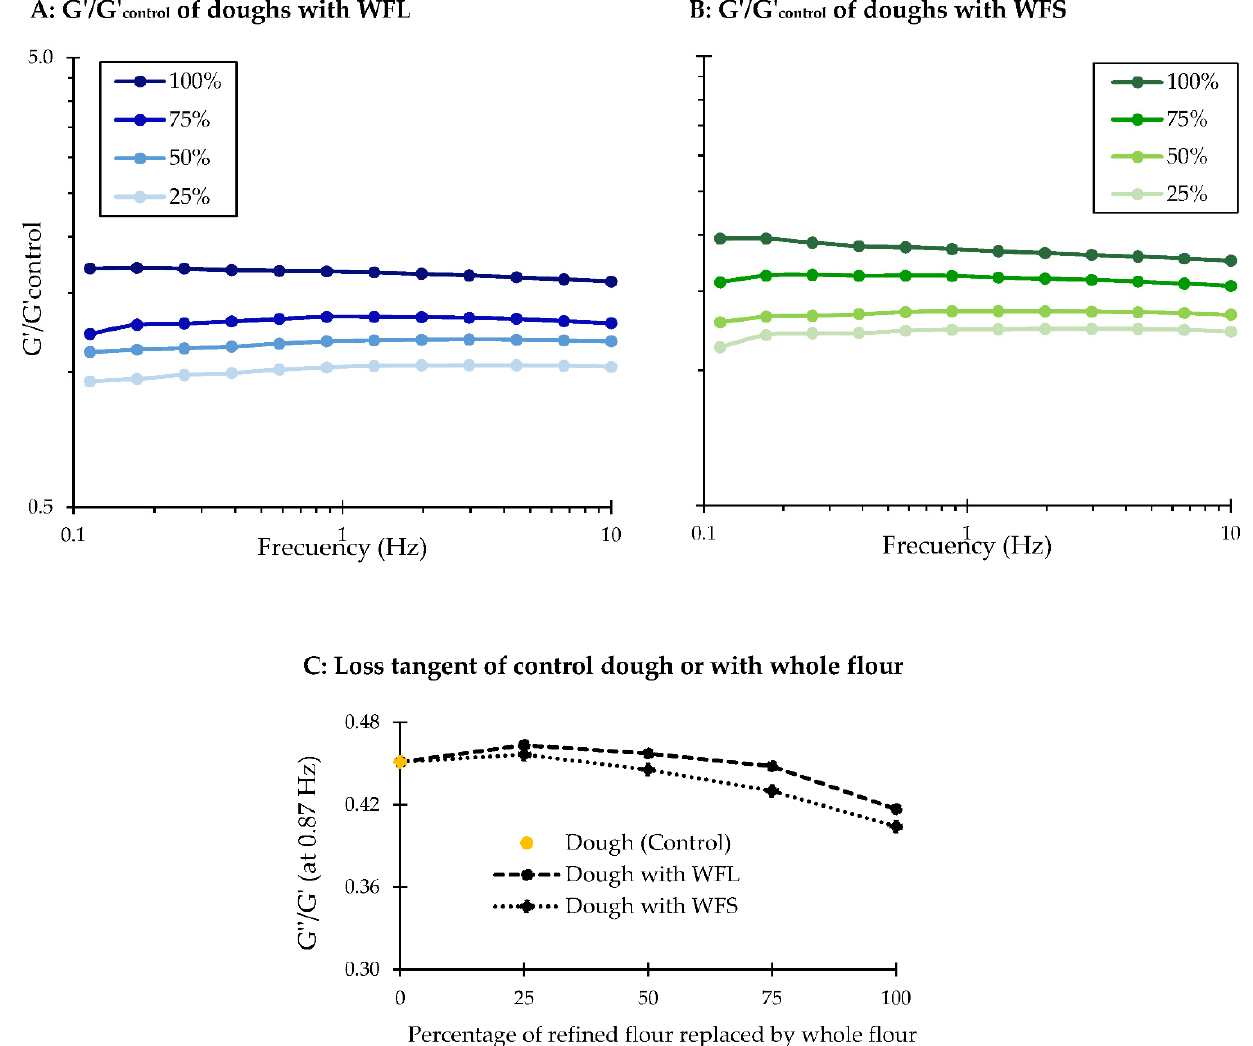
Figure 2. Frequency sweep curves represented by G’/G’control (where the control corresponds to the dough prepared with refined flour) as a function of frequency (Hz) of doughs prepared by replacing 25, 50, 75 or 100% of the refined flour with whole flour with coarse bran (WFL) ( A ) or whole flour with fine bran (WFS) ( B ). The loss tangent curves (G”/G’) as a function of replacement at a frequency of 0.87 Hz are also shown ( C ).